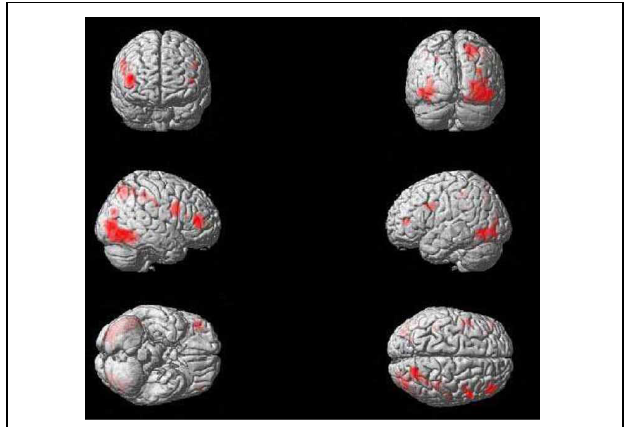
FIGURE 4 | Significant activations for self vs. familiar-other contrast, thresholded at p < 0 . 0005, with a contiguity threshold of 20 voxels. Activations are shown on an individual brain rendered in 3D.